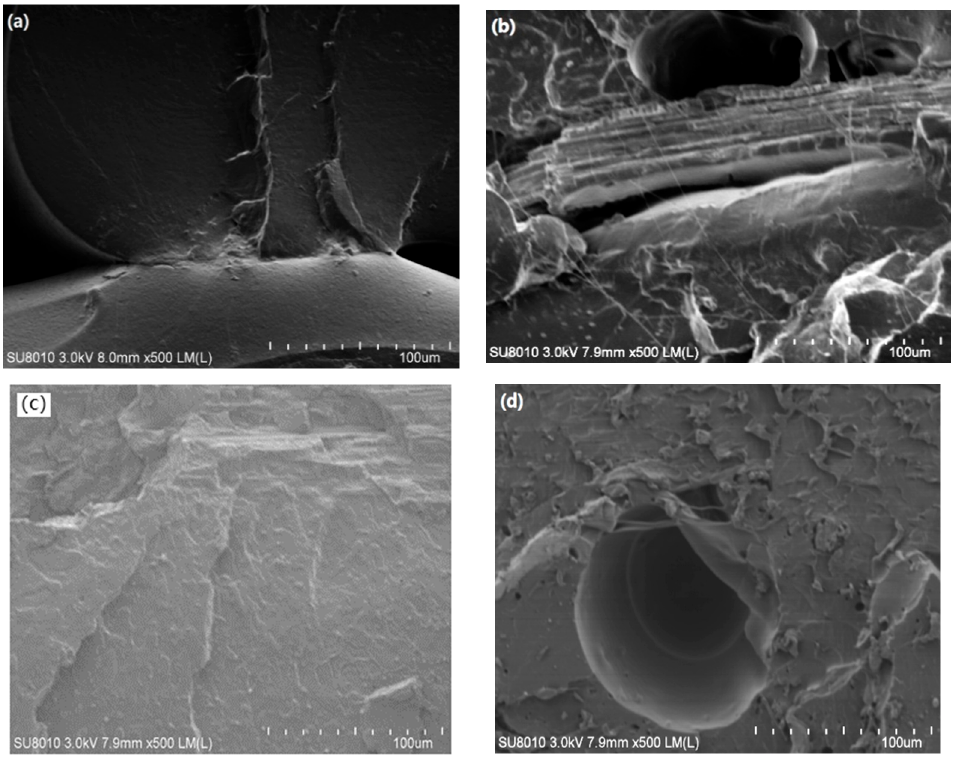
Figure 2. SEM micrograph of cross section of 3D-printed specimen of ( a ) raw PLA, ( b ) 60#RSP/PLA, ( c ) 120#RSP/PLA, and ( d ) 200#RSP/PLA. Scale bars in ( a – d ) indicate 100 μ m.